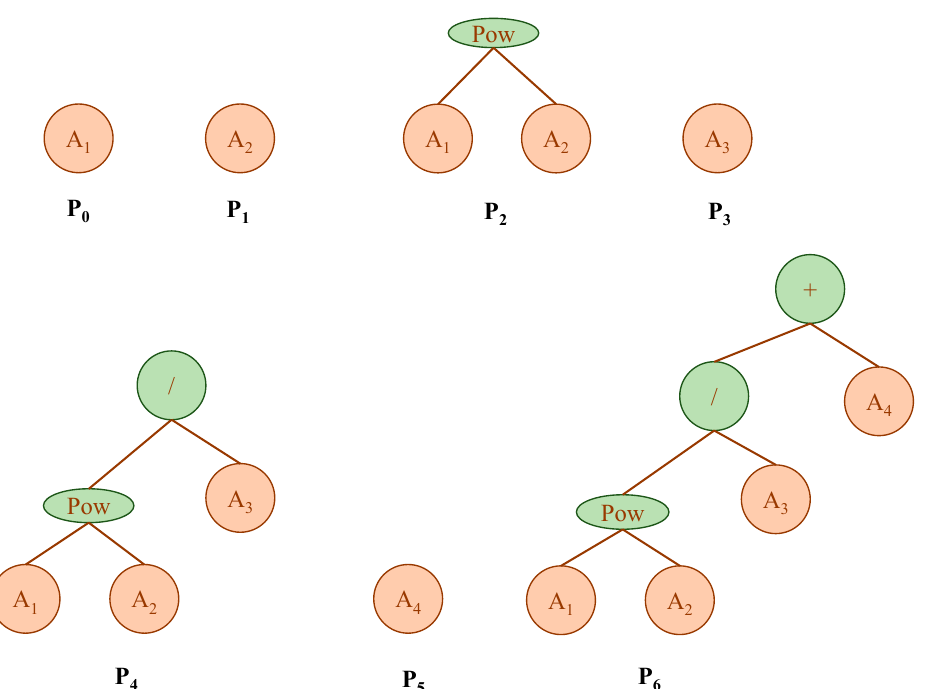
Figure 1. Trees (Genes) in MEP representing the expression using chromosome.